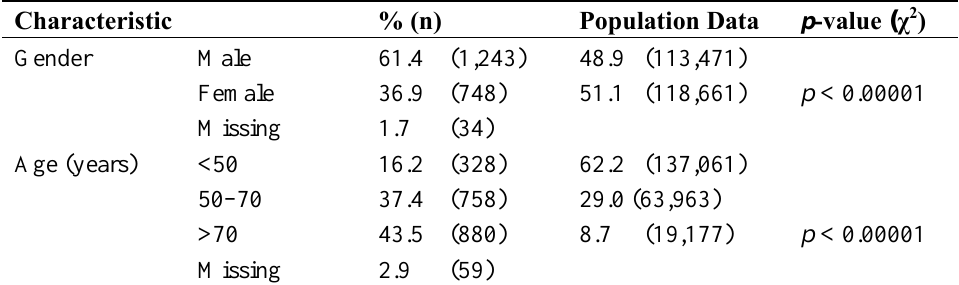
Table 1. Sample demographics (n = 2,025) compared to population